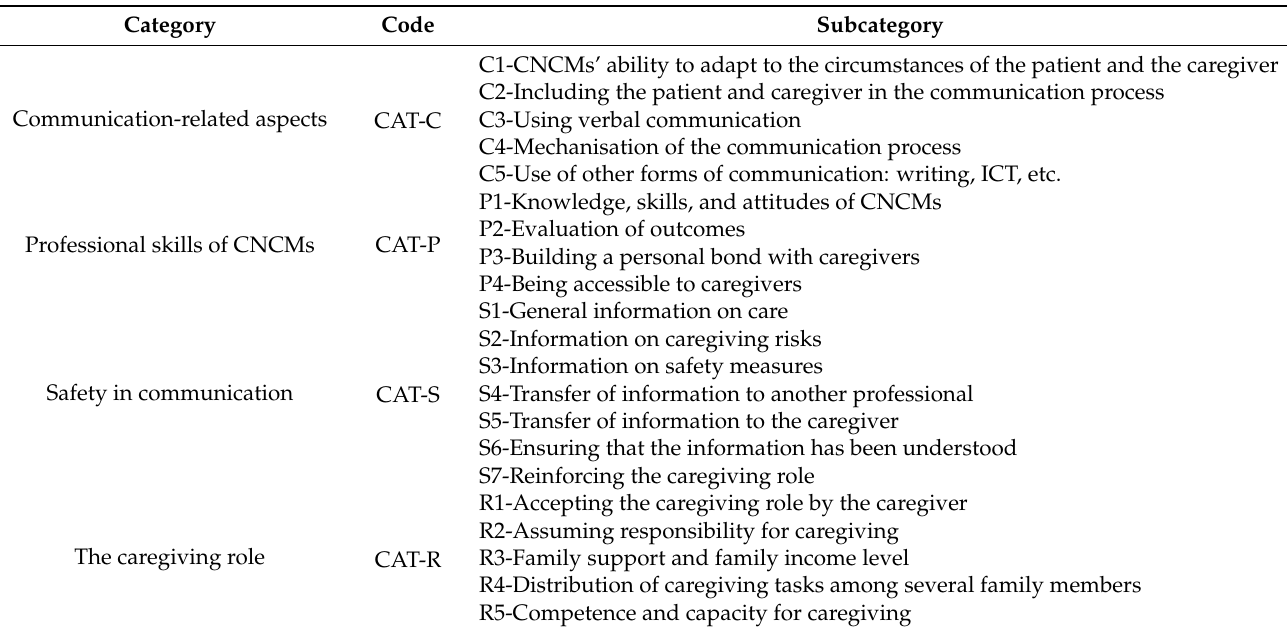
Table 1. Interrelationships between categories, codes, and subcategories.